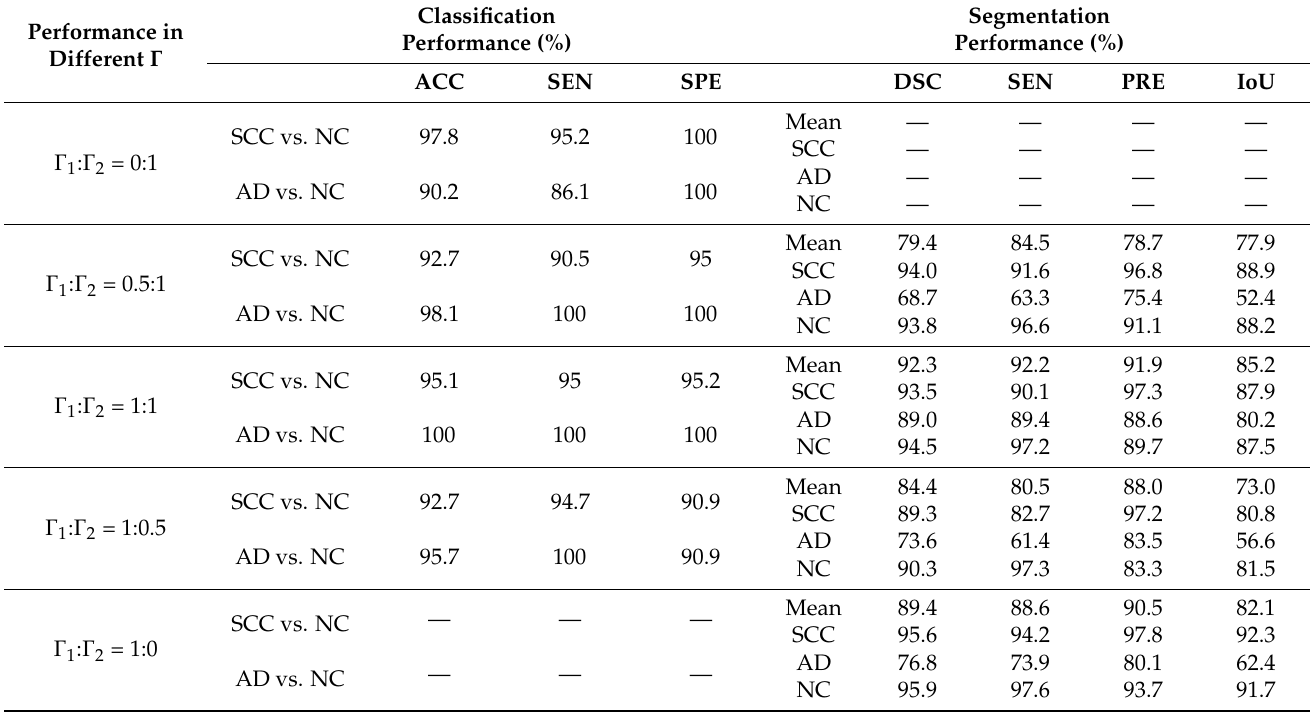
Table 2. Performance of classification and segmentation after assigning different weights to their respective